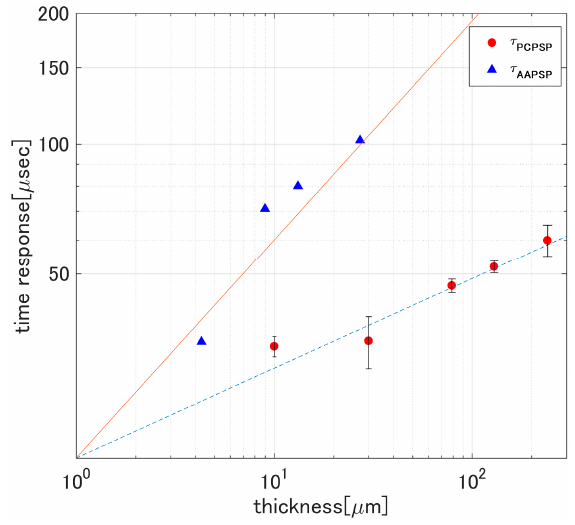
Figure 9. Comparison of time response for PC-PSP and AA-PSP [21].